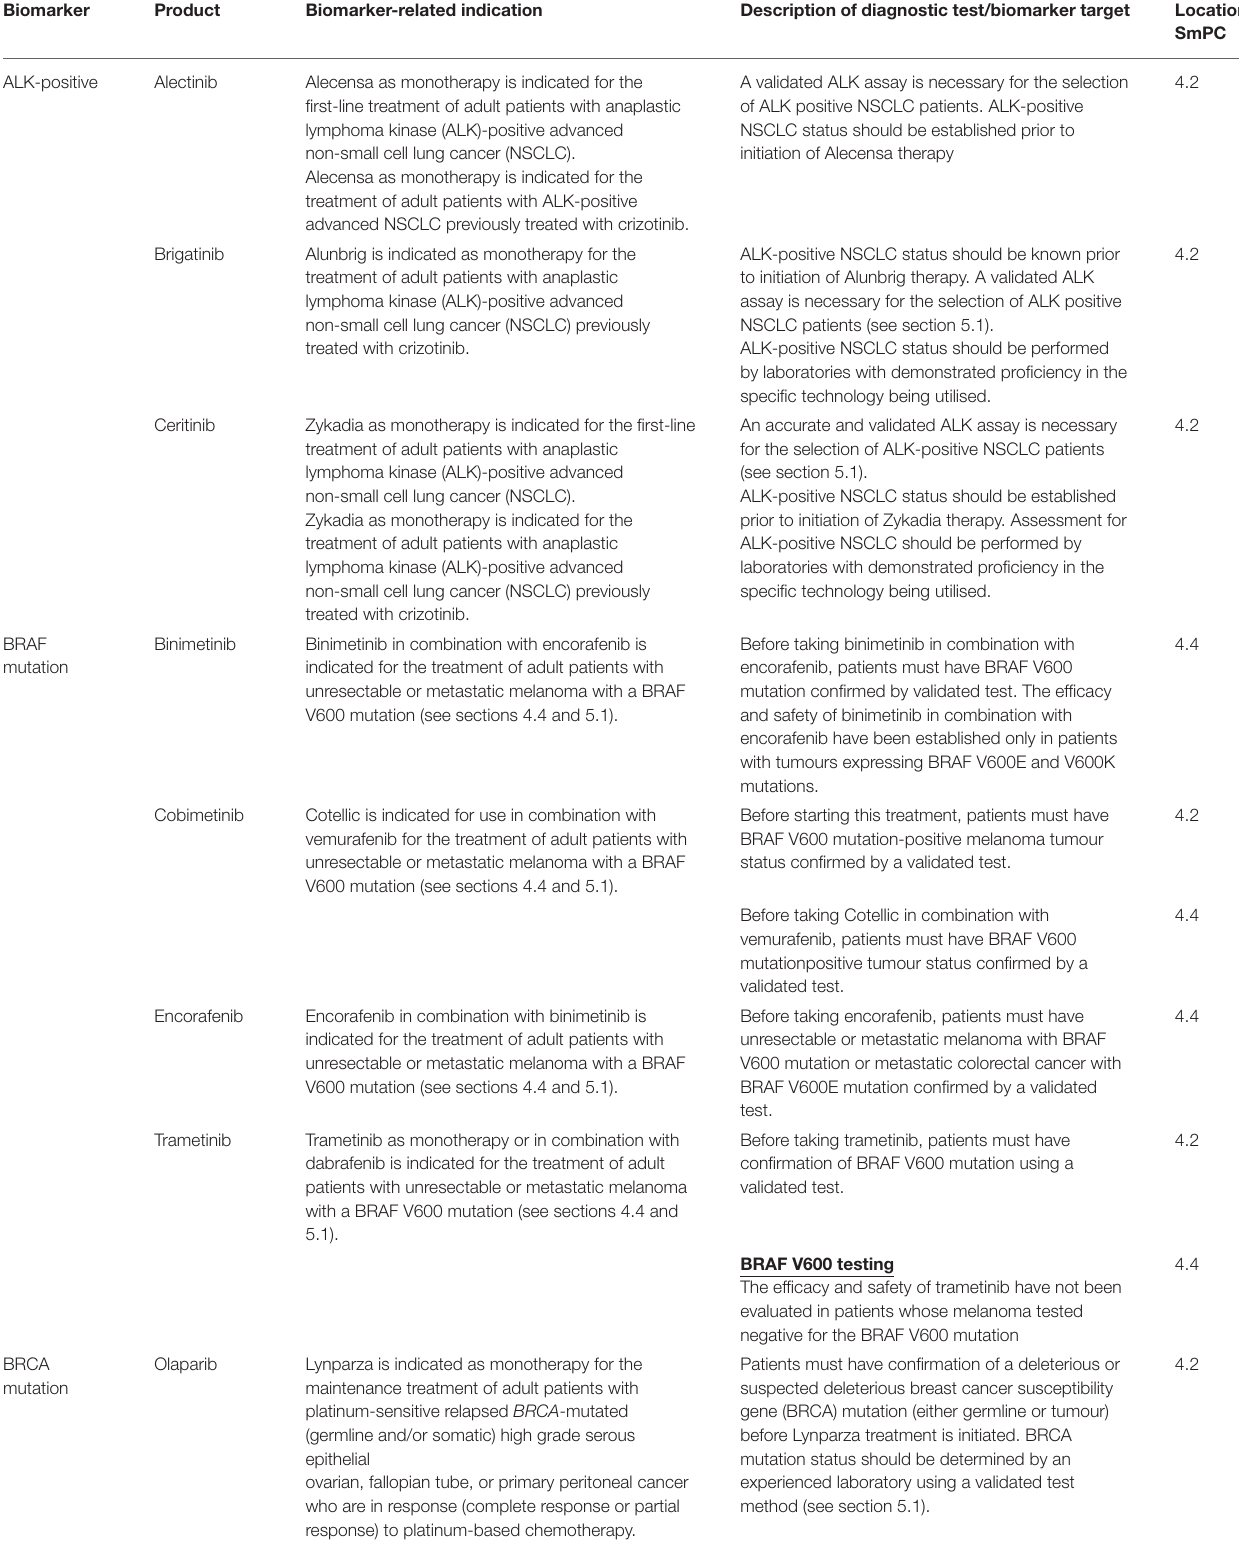
TABLE 4 | Medicinal products categorised by the biomarker target of the diagnostic